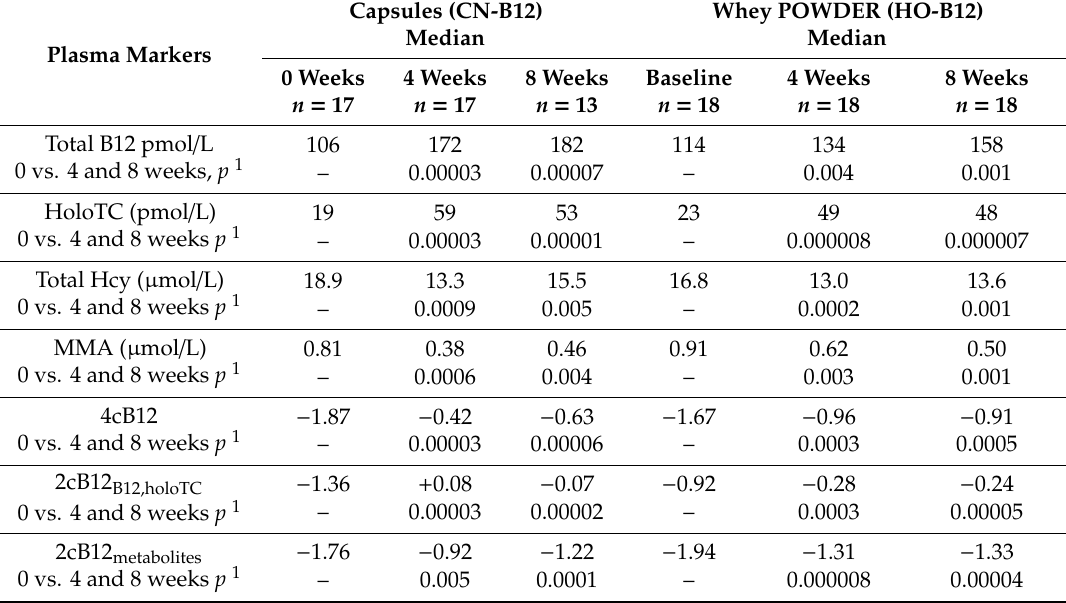
Table 2. Nonparametric comparison of the treatment outcomes at weeks four and eight vs. the respective baselines for participants receiving CN-B12 capsules or whey